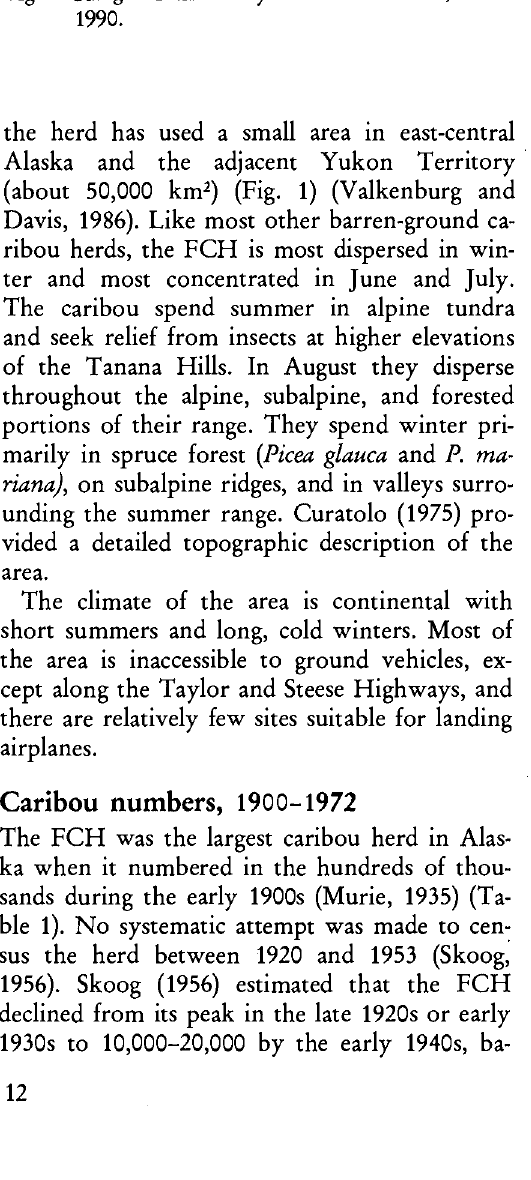
Fig. 1. Range of the Fortymile caribou herd, 1968¬